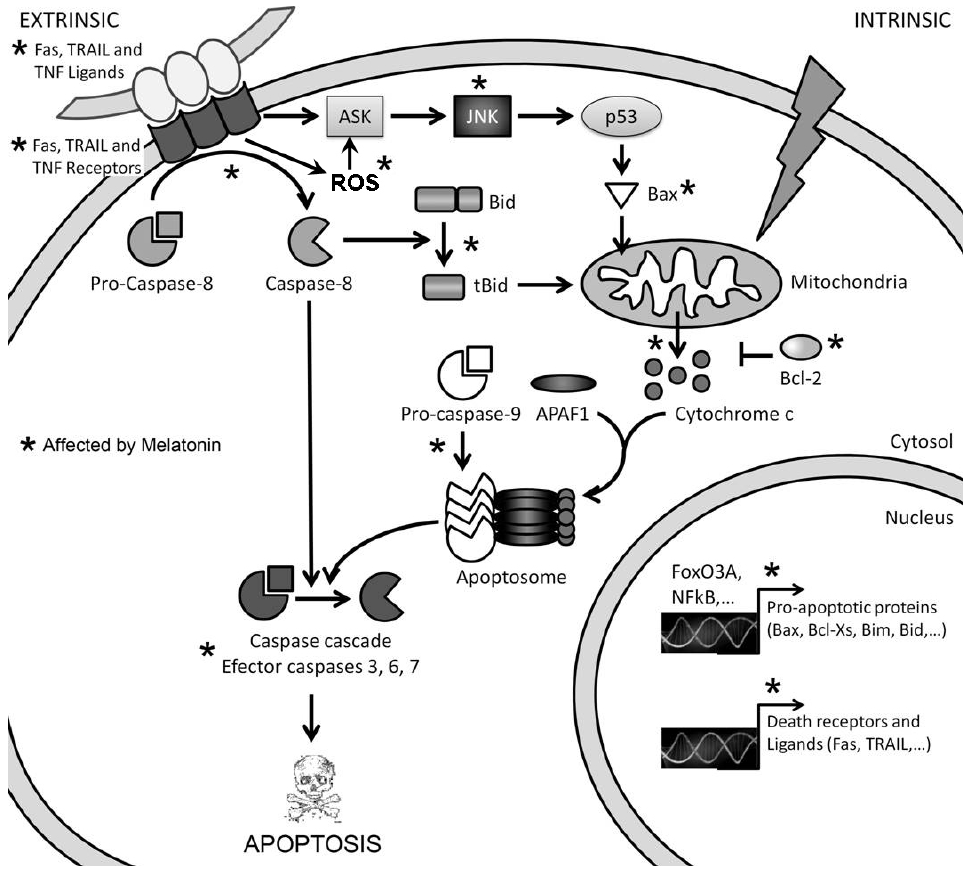
Figure 3. General view of the extrinsic and the intrinsic pathways of apoptosis. * Affected by